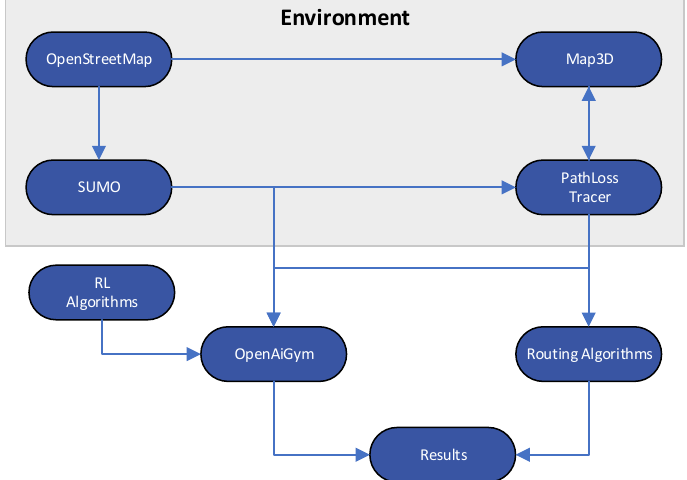
Figure 2. Simulation diagram.